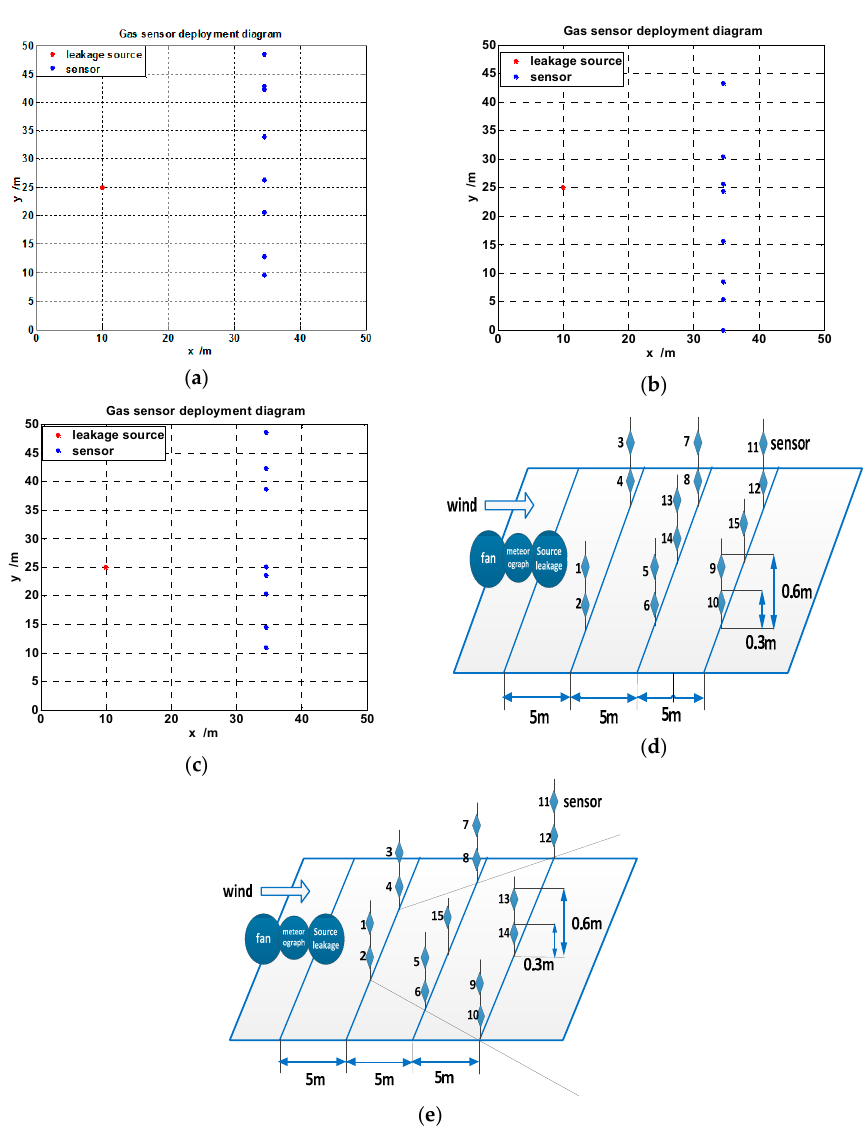
Figure 5. ( a ) The gas sensor deployment diagram based on WGABC algorithm; ( b ) The gas sensor deployment diagram based on PSO algorithm; ( c ) The gas sensor deployment diagram based on DE algorithm; ( d ) The rectangular gas sensor deployment diagram according to the standard; ( e ) The sector gas sensor deployment diagram according to the standard.